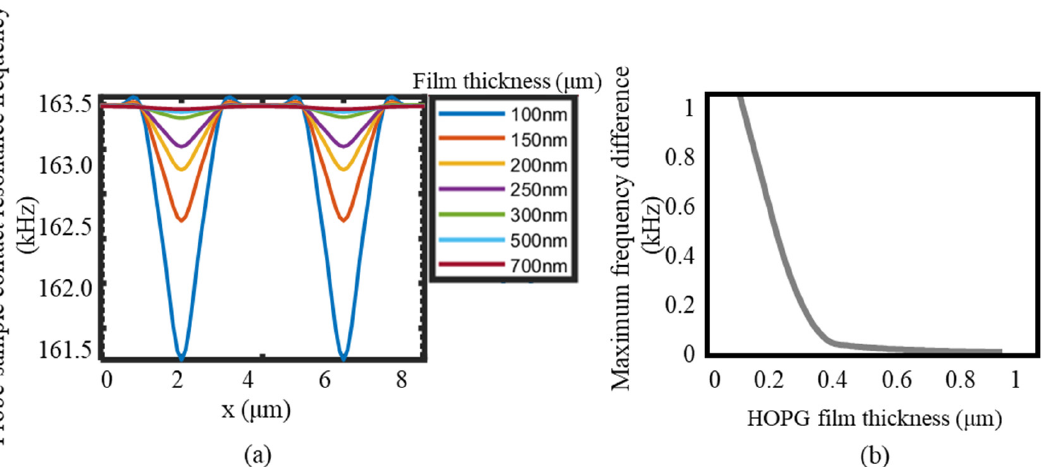
Figure 5. Finite element simulation results. ( a ) shows the change in the contact resonance frequency of the probe sweeping across the sample surface of 8 μ m when the surface HOPG film thickness is different. ( b ) shows the variation of the maximum contact resonance frequency difference during the scanning process with the increase of the HOPG film thickness.